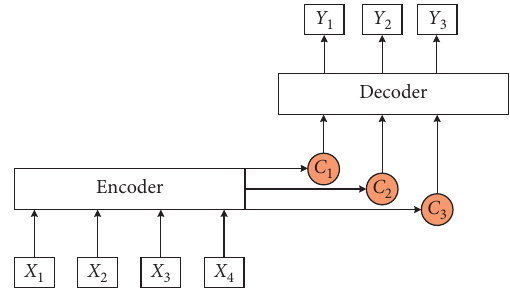
Figure 7: Encoder-decoder model combined with Attention mechanism.